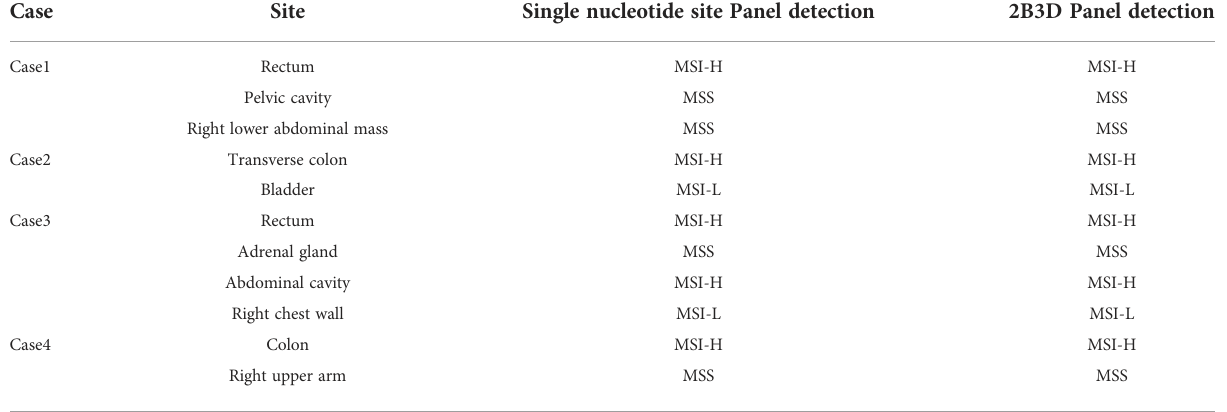
TABLE 3 Summary of single nucleotide sites and NCI 2B3Dpanel test